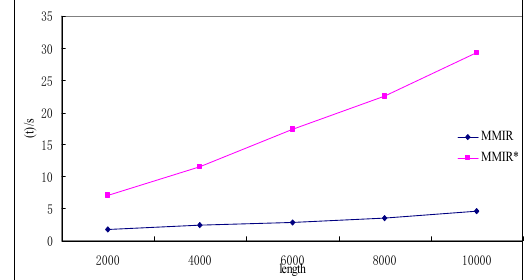
Fig 10. Performance of algorithms for MMIRTS Figure 10 depicts the increase of computing time with the increase of time series’ length. MMIR denotes the MMIRTS algorithm using traditional correlation. MMIR * denotes the MMIRTS algorithm using directional correlation. Because calculating both the directional correlation only need to scan the whole time series constant times, so the complexity of MMIRTS using